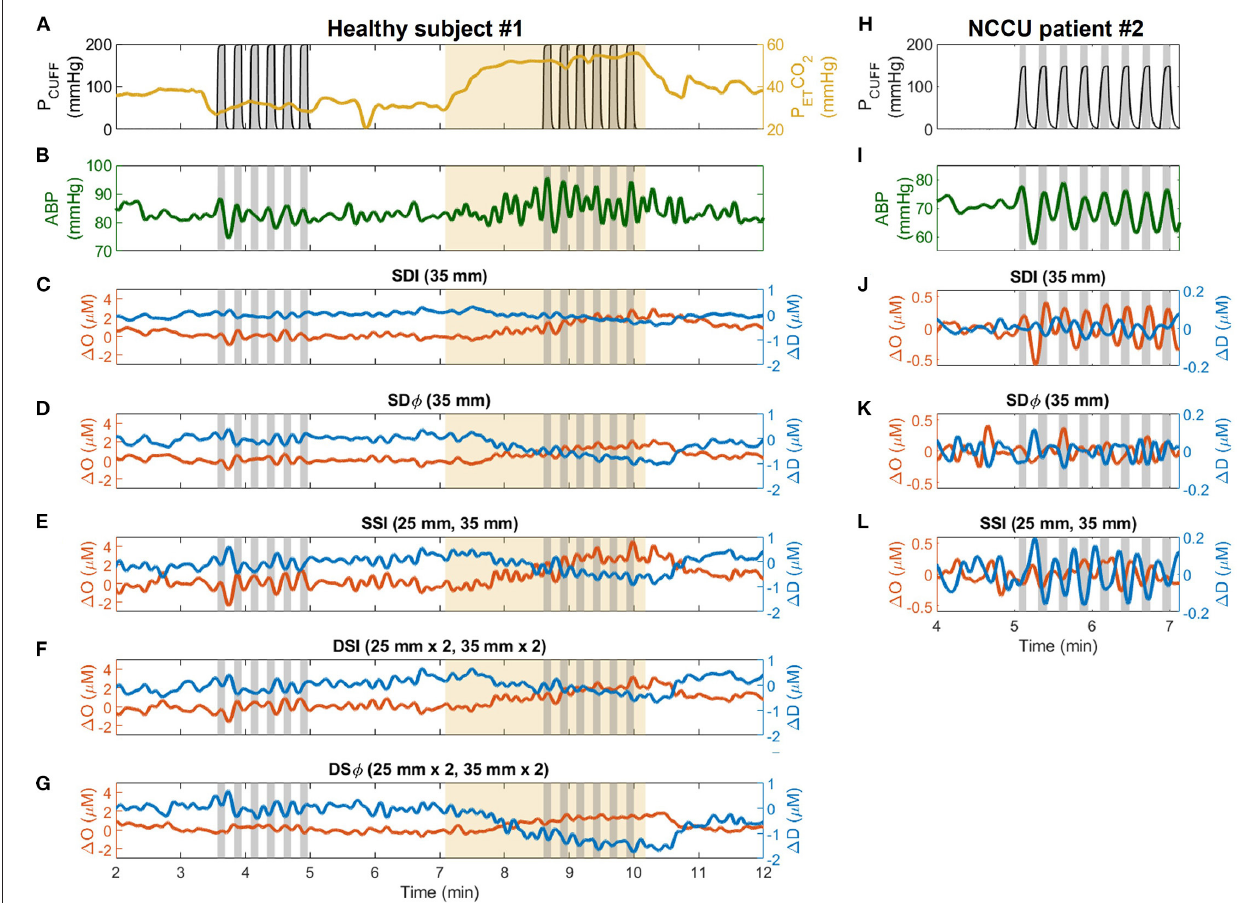
FIGURE 2 | Representative time traces collected during the experiment on healthy subjects (subject 1, left column) and patients in the neurocritical care unit (NCCU) (patient 2, right column). For the healthy subject, signals are shown for pneumatic thigh cuff pressure (P CUFF , black , A ), end-tidal carbon dioxide pressure (P ET CO 2 , yellow , A ), arterial blood pressure (ABP, green , B ), and changes in oxyhemoglobin ( 1 O , red ) and deoxyhemoglobin ( 1 D , blue ) measured with single-distance intensity (SDI 2A, 35 mm, C ), single-distance phase (SD φ 2A, 35 mm, D ), single-slope intensity (SSI 1AB, 25 and 35 mm, E ), dual-slope intensity (DSI 1AB2, 25 and 35 mm, F ), and dual-slope phase (DS φ 1AB2, 25 and 35 mm, G ). For the NCCU patient, signals are shown for P CUFF (H) , ABP (I) , and for 1 O and 1 D measured with SDI (35 mm, J ), SD φ (35 mm, K ), and SSI (25 and 35 mm, L ). Gray shaded areas indicate the cuff inflation periods (from start of inflation to start of deflation). Thigh cuffs were inflated and deflated at a frequency of 0.066 Hz for healthy subjects and at 0.063 Hz for NCCU patients. Yellow shaded areas indicate hypercapnic interval. ABP and optical signal traces are lowpass filtered to 0.1